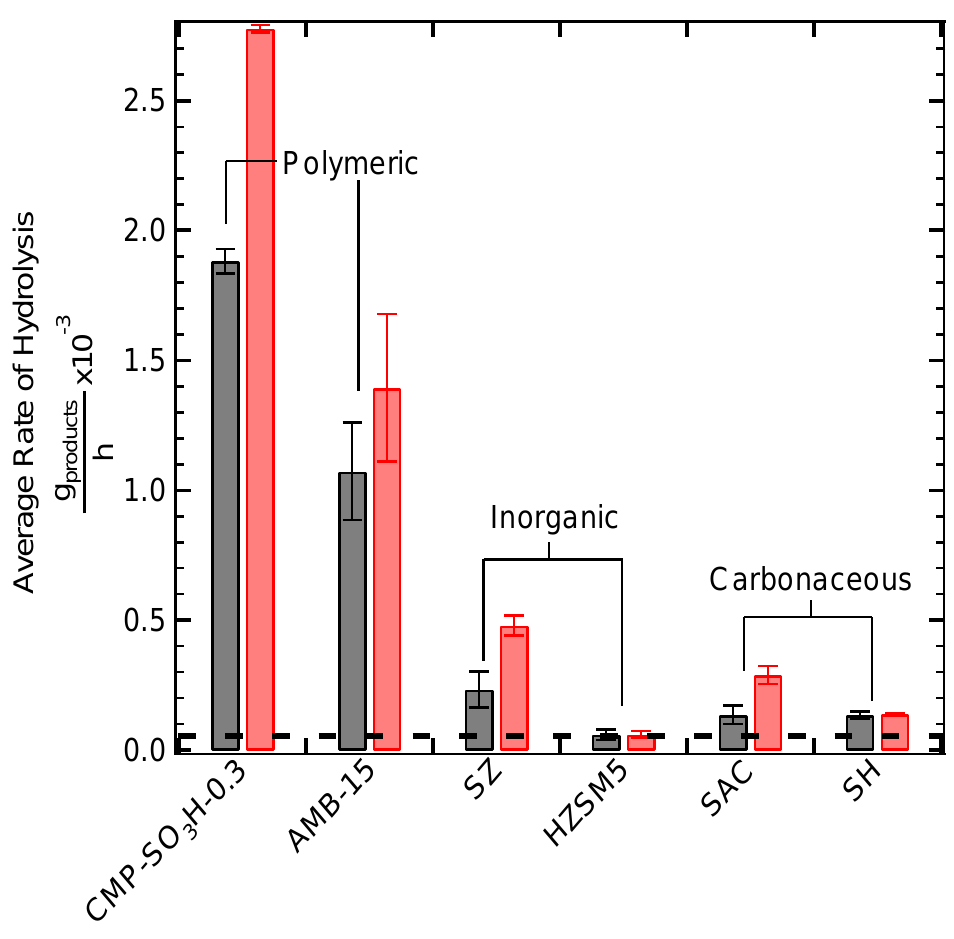
Figure 2. Comparison of average product formation rate after cellulose hydrolysis with fresh solid acid catalyst (gray bars) and supernatant (red bars). The dotted line represents the activity of water-only in the absence of catalyst at the same conditions. Conditions: 150 ◦ C ( ± 2.5 ◦ C) reaction temperature and either 10 or 15 h reaction time, 2 mL of water, 0.1 g of cellulose, and 0.2 g of catalyst.